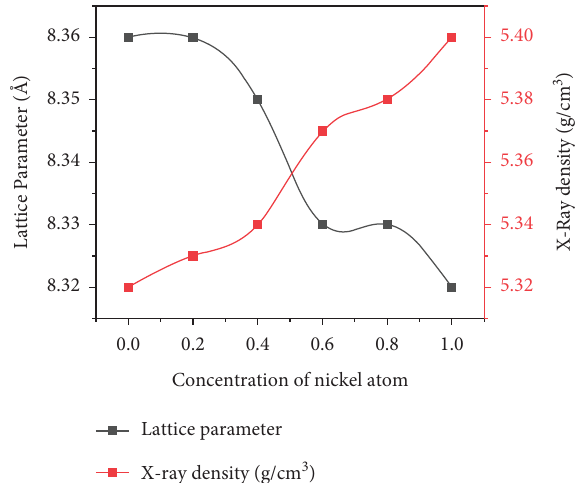
Figure 5: Variation of lattice parameter ( a ) and X-ray density ( ρ as functions of Ni 2+ content.